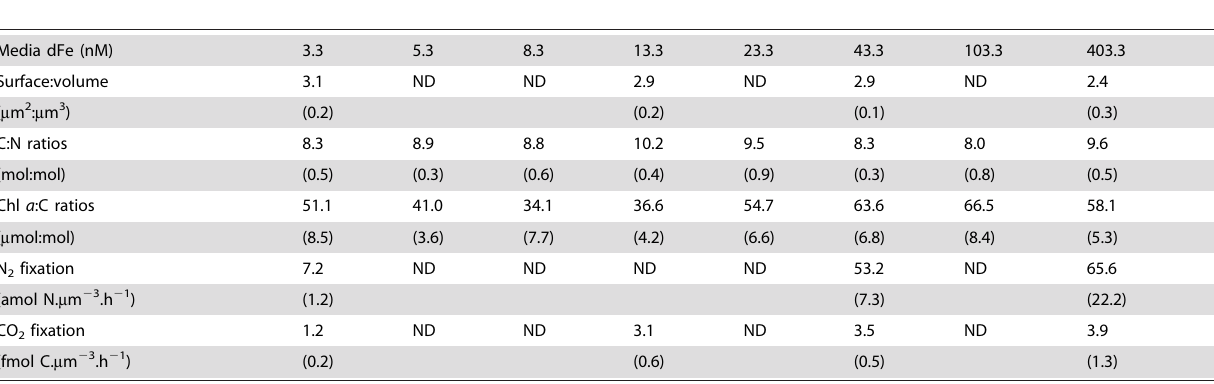
Table 1. Influence of dFe concentrations in the cultures on surface:volume ratio, elemental ratios, cellular and volume-normalized N 2 and CO 2 fixation rates of C. watsonii WH8501 (numbers in brackets represent standard deviation).